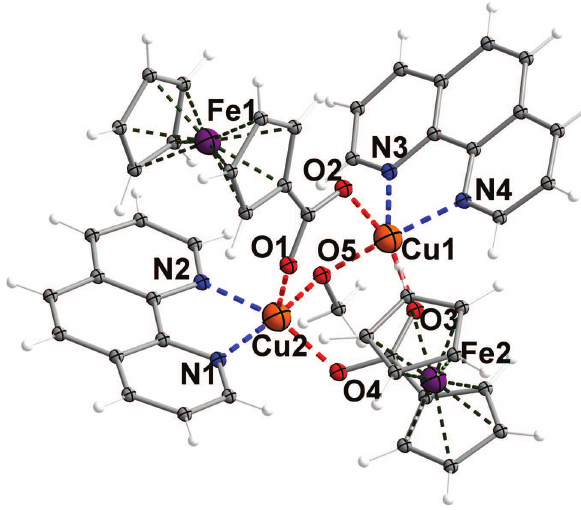
Table 1: Data collection and